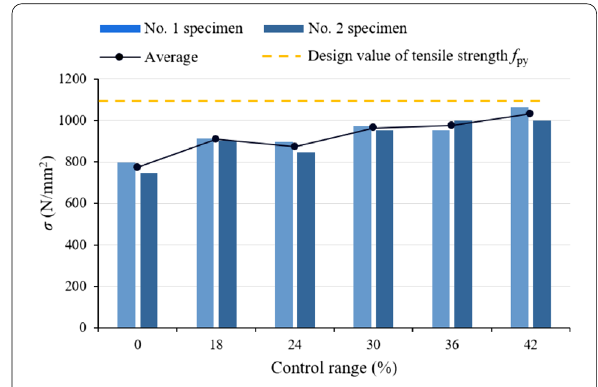
Fig. 12 Tendency graph of steel wire